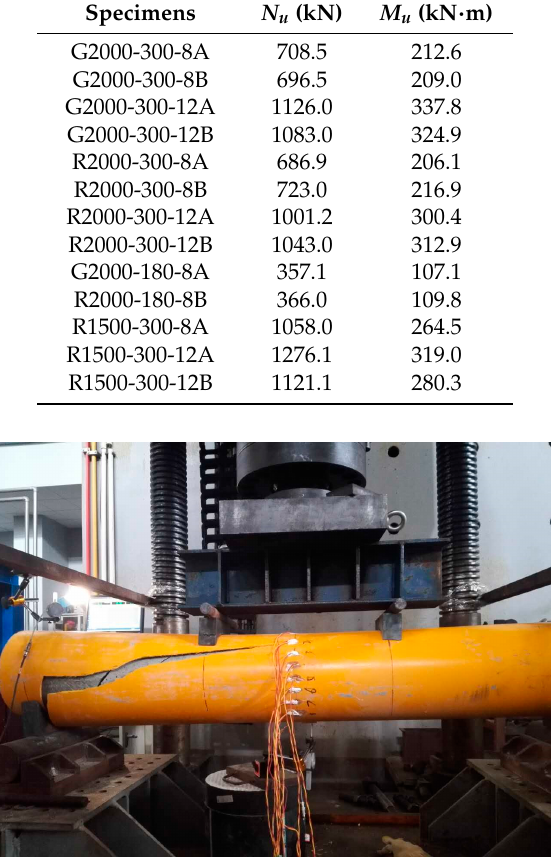
Figure 9. Failure mode of test specimen G-2000-300-8B.